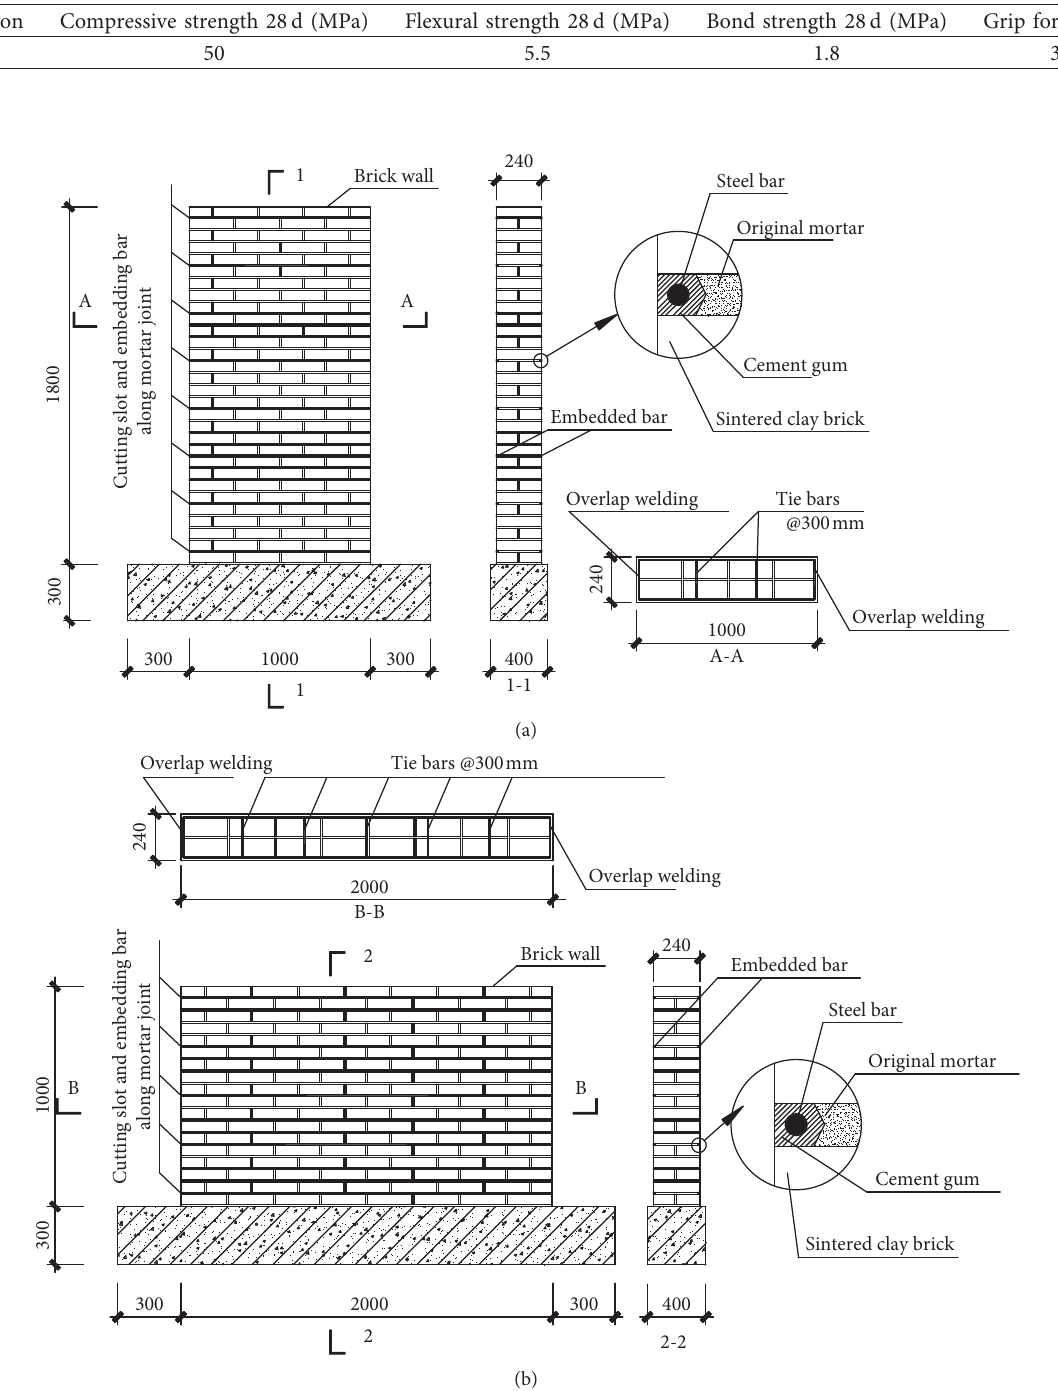
Figure 1: Geometry size and reinforcement of the specimens. (a) Geometry size and reinforcement of the specimen with aspect ratio of 1.80. (b) Geometry size and reinforcement of the specimen with aspect ratio of 0.50.